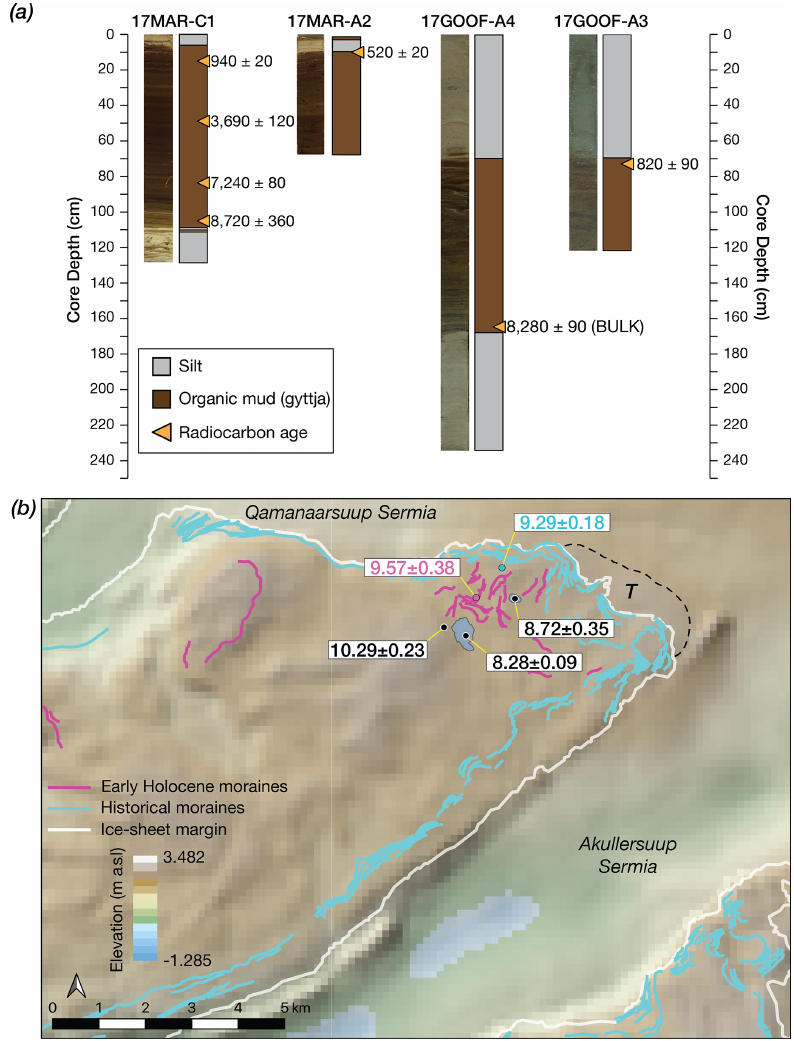
Figure 6. (a) Sediment cores and calibrated radiocarbon ages ( ± 2 σ ) from Marshall (MAR) and Goose Feather (GOOF) lakes. Note the distinct color differences between silt and organic sediments (see Figs. 3 and 4). Details for radiocarbon ages can be found in Table S7. (b) Sub-ice topography in the Qamanaarsuup Sermia region generated using the BedMachine v3 digital elevation model (Morlighem et al., 2017) compared to our chronology of ice-margin change developed from 10 Be ages and radiocarbon-dated lake sediments (panel a ). Shown is the average 10 Be age from each feature on the landscape (including production-rate uncertainty; see Fig. 3) and basal radiocarbon ages from panel (a) . Deglaciation of the landscape just outboard of the Kapisigdlit stade moraines occurred at 10 . 29 ± 0 . 23ka, followed by moraine deposition at 9 . 57 ± 0 . 38ka. Ice retreated behind the modern margin at 9 . 29 ± 0 . 18ka, but the ice margin remained within the drainage catchment of Goose Feather Lake until 8 . 28 ± 0 . 09calka before retreating farther inland. The dashed line delimits the topographic threshold (T) under the modern GrIS that the ice margin must cross in order for Goose Feather Lake to receive silt-laden meltwater. Inflow of meltwater ceases when the GrIS margin retreats behind this topographic threshold, which rests ∼ 1km behind the modern